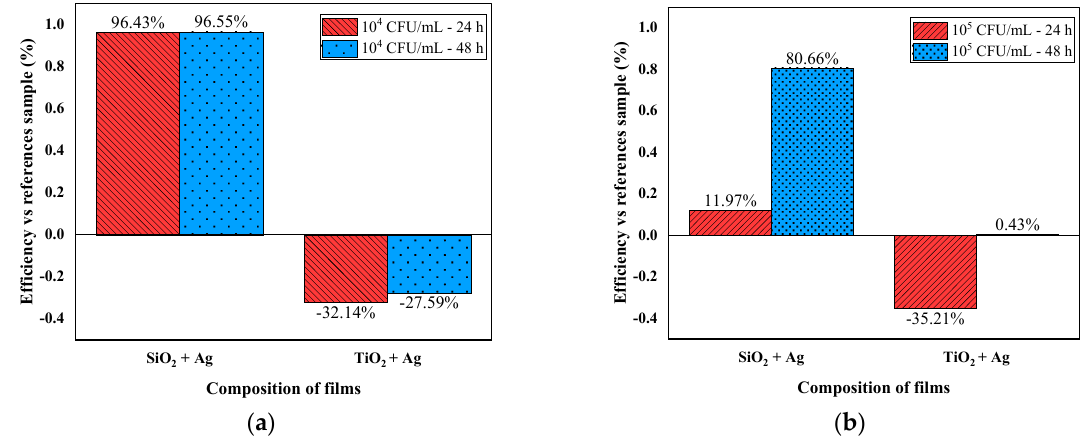
Figure 4. Antibacterial efficacy depending on the type of film and on the incubation time-24 h and 48 h-and the applied Escherichia coli inoculum concentration: ( a ) 10 5 CFU/mL and ( b ) 10 4 CFU/mL. Figure 4b shows a percentage of 96.43% for the antimicrobial efficiency of the sample coated by SiO 2 + Ag, at the concentration of 10 5 CFU/mL, after 24 h and 96.55% after 48 h of incubation, so bacterial growth was much poorer at both incubation intervals than the reference sample. As a result, increased antibacterial potential was obtained at the concentration of 10 4 CFU/mL as compared to the tests performed at the concentration of 10 5 CFU/mL for the samples coated by SiO 2 + Ag. For samples coated by TiO 2 + Ag, the bacterial proliferation may have occurred due to a lack of UV radiation stimuli, given that ROS species interact with the bacterial cell membrane. The ROS are thought to first interact with the bacterial membrane, causing oxidative damage and breaking the cell wall, exposing the bacteria’s internal compartment to the external environment. This action causes the uncontrolled flow of components into and out of the cell, eventually leading